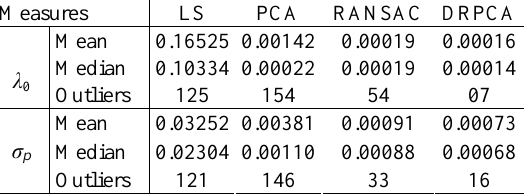
Table 4. Measures based on λ 0 and σ p from 1000 samples